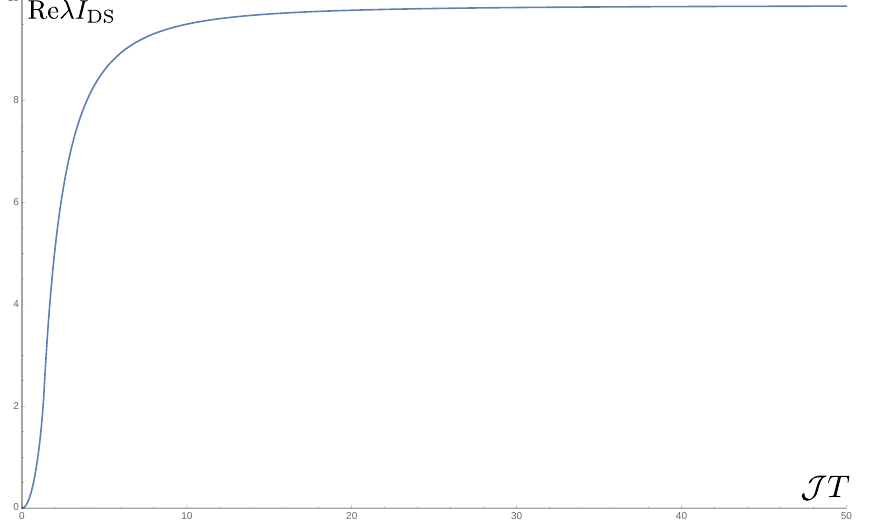
Figure 5 . Real part of the action on a slope saddle point as a function of